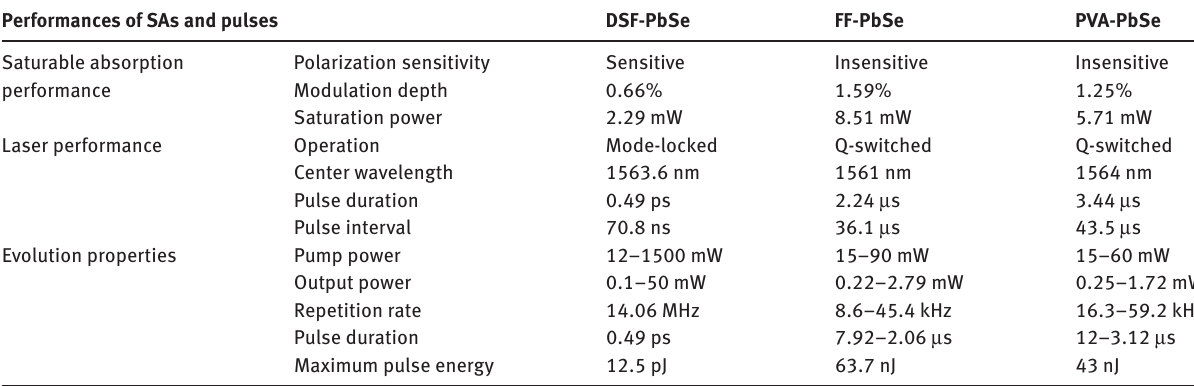
Table 1: Summarizations of three PbSe SAs and corresponding laser performances. Performances of SAs and pulses